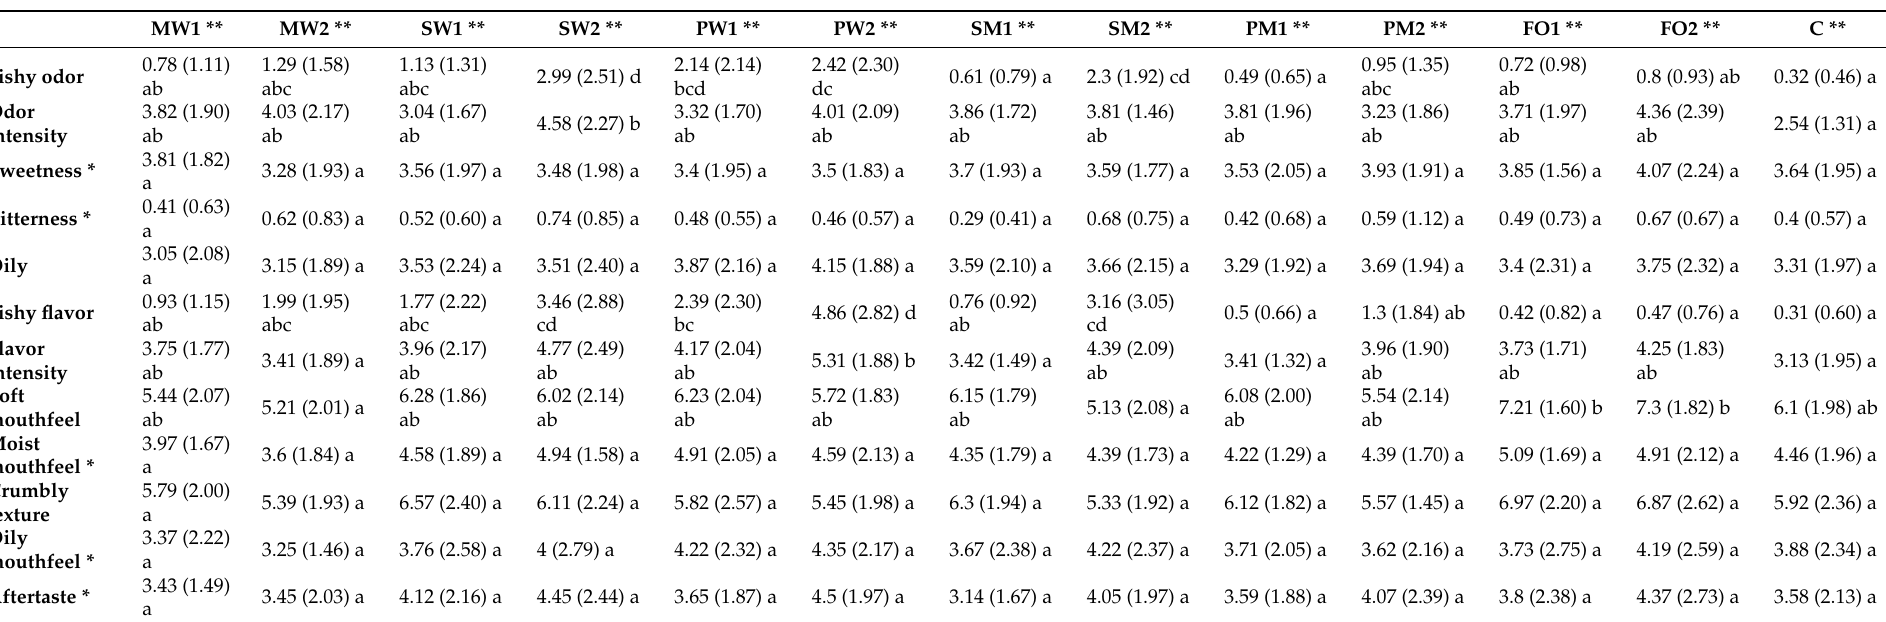
Table A2. Mean intensities and standard deviations (in brackets) of attributes in the descriptive analysis of the cookies models. The statistical differences between the samples are marked with letters a-f (Tukey’s HSD test, p < 0.05). The lowest values are marked with letter a, and samples with the same letter on the same row are not different from each